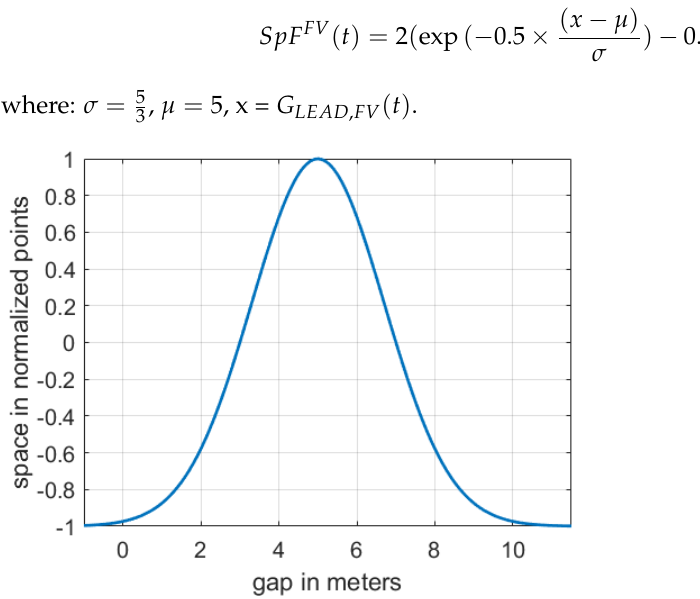
Figure 4. FV’s space function depending on the cooperation level regarding willingness to let EGO merge (scored points) and the headway or gap between FV and LEAD in